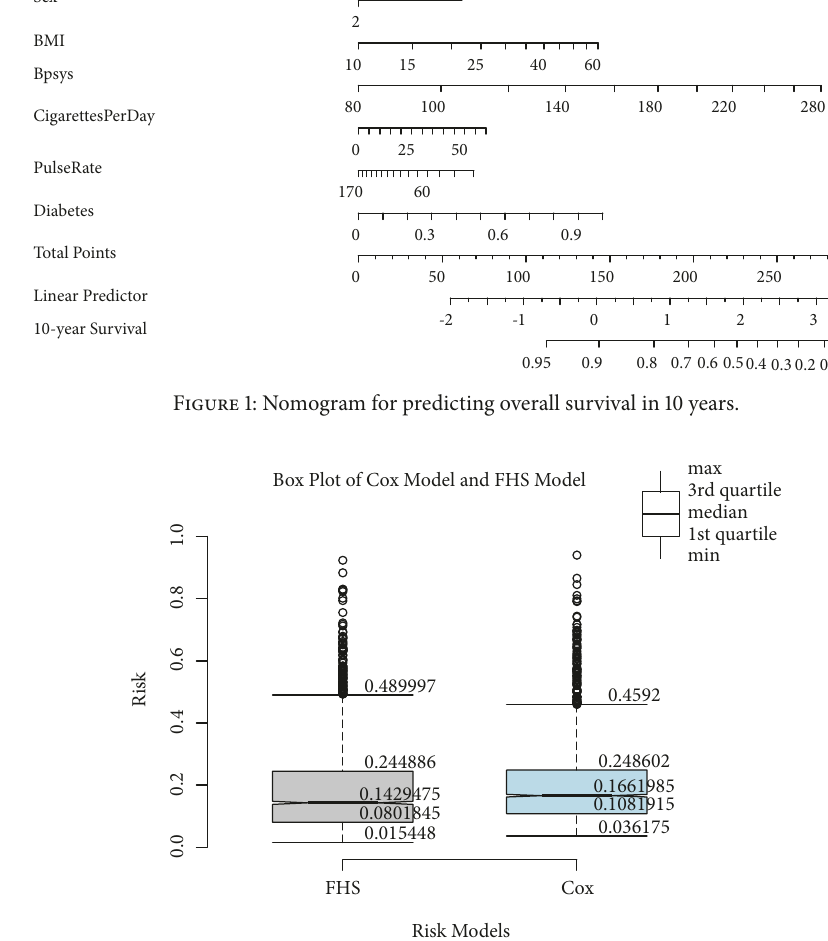
Figure 2: Horizontal comparison between Cox model and FHS model.